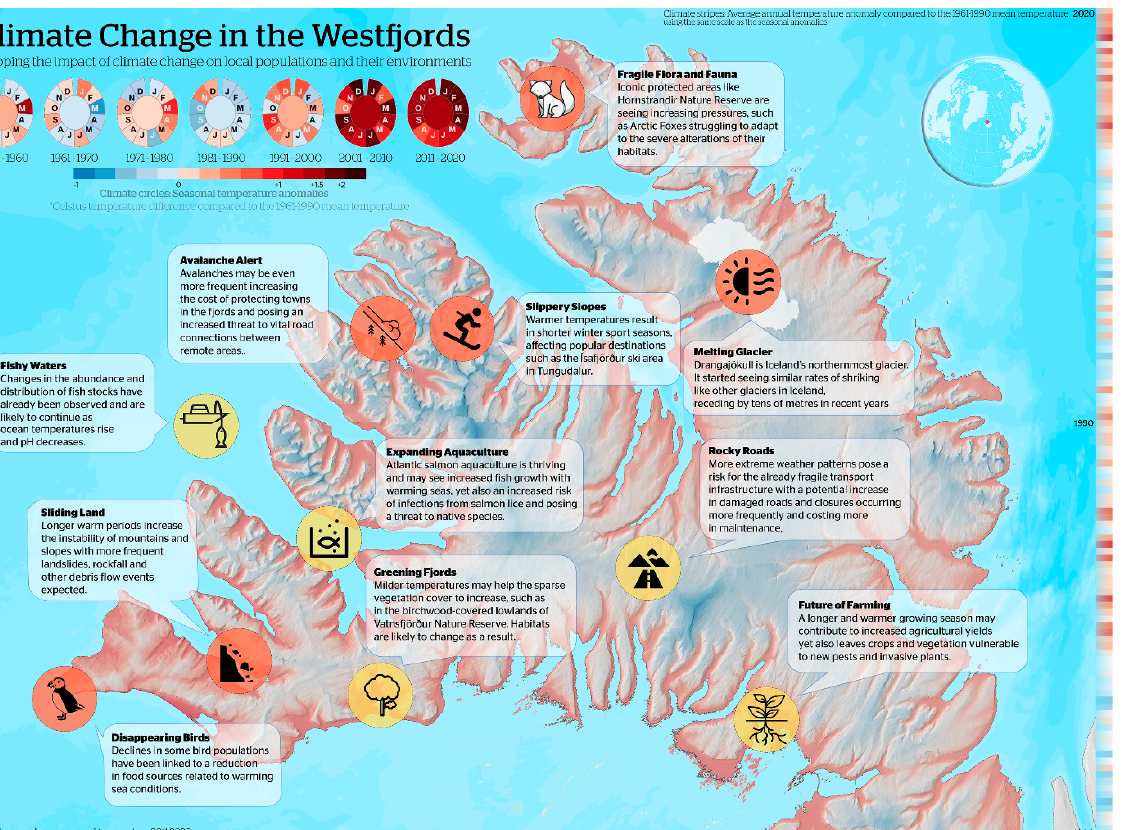
Figure 11. The major physical impact due to climate change is associated with the increased instability of the many slopes that characterize the landscape of the region to a large extent.